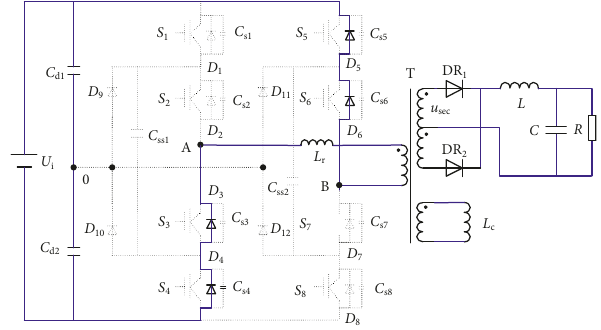
Figure 13: Equivalent circuit of mode 5.